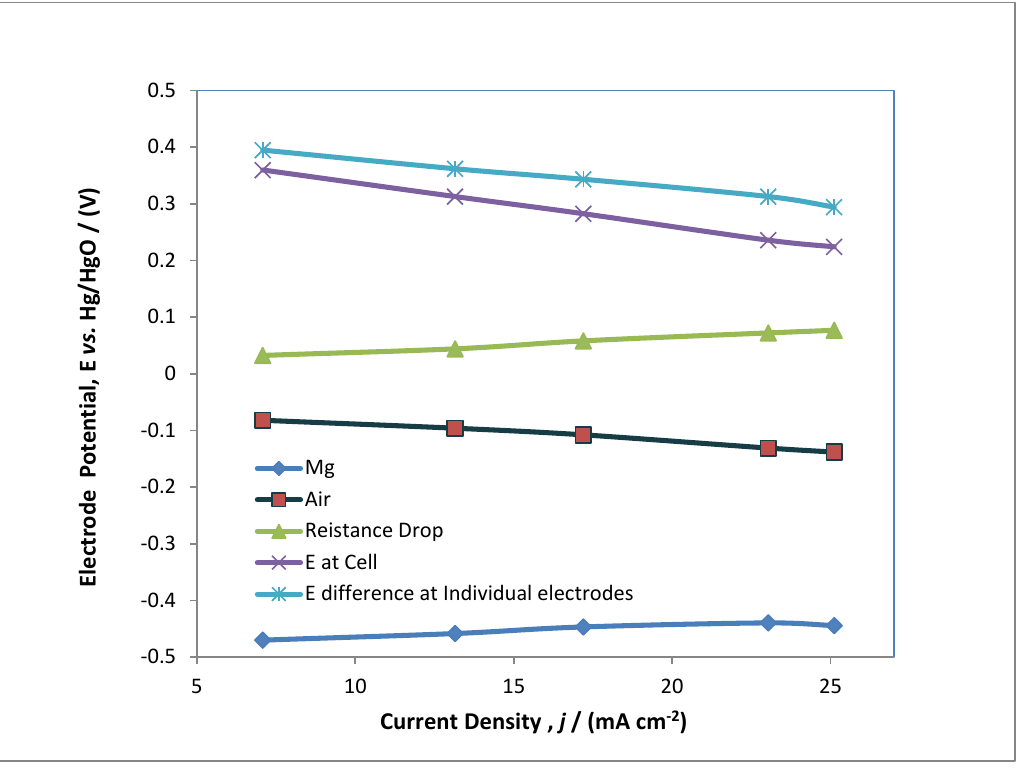
Figure 8. The variation in individual electrode potentials for Mg, air, resistance IR drop and cell potential at increasing applied current densities.